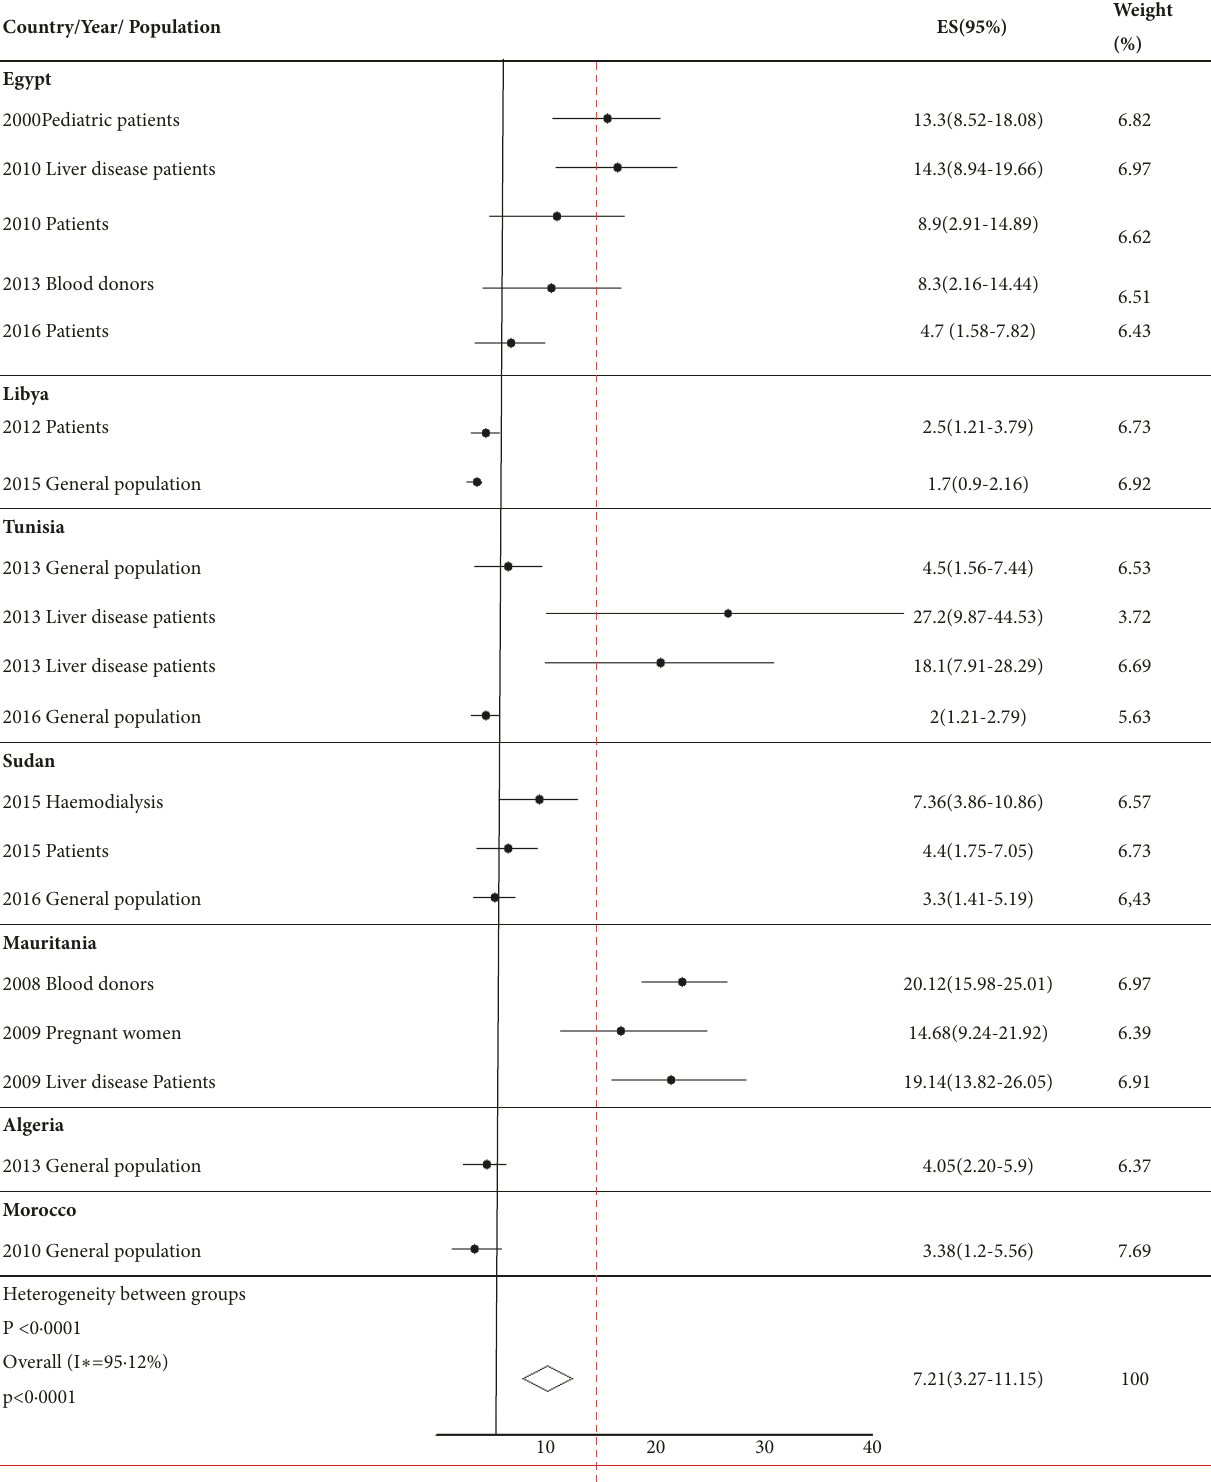
Figure 3: Forest plot of the seroprevalence of hepatitis D virus in different populations in North